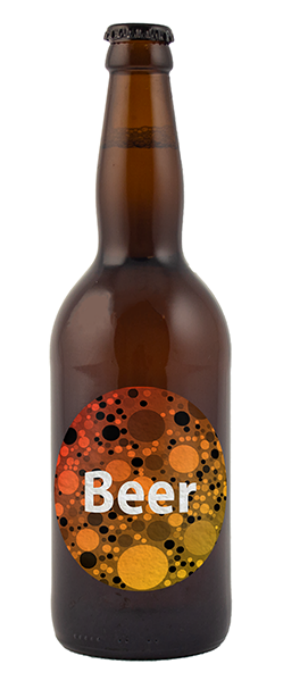
Figure 4. Levels for design factor “Bottle Shape”. Technical drawings based on actual bottles, in units of millimeters.